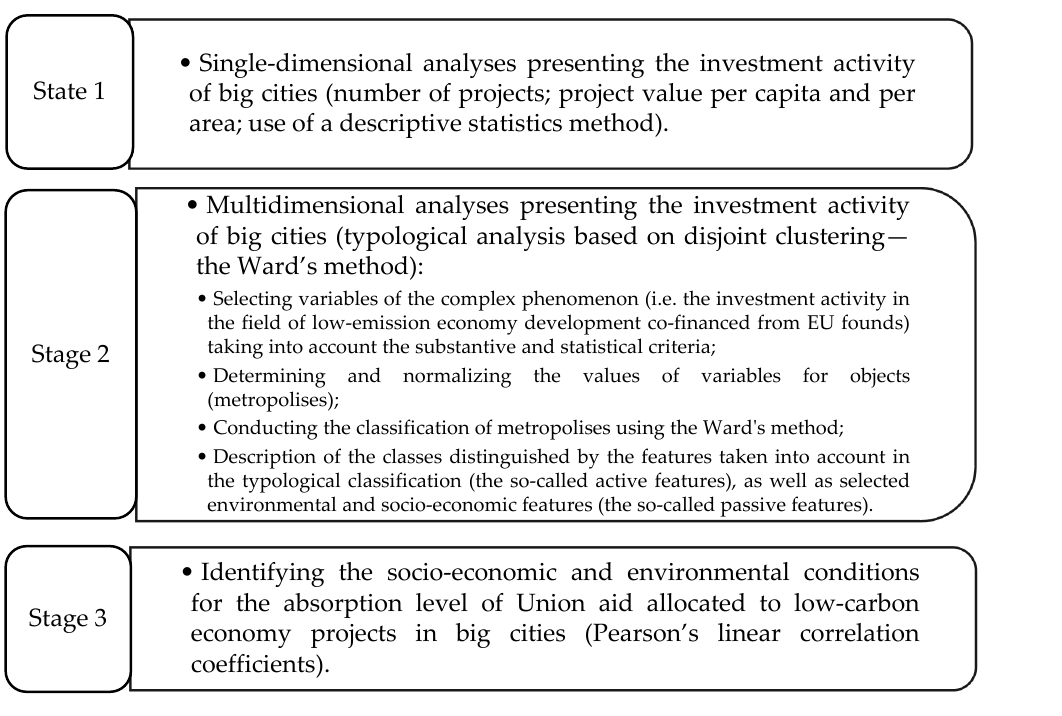
Figure 1. Procedure for evaluating the levels of investment in the low-carbon economy, co-financed with EU funds, in Polish metropolises. Source: Own study.